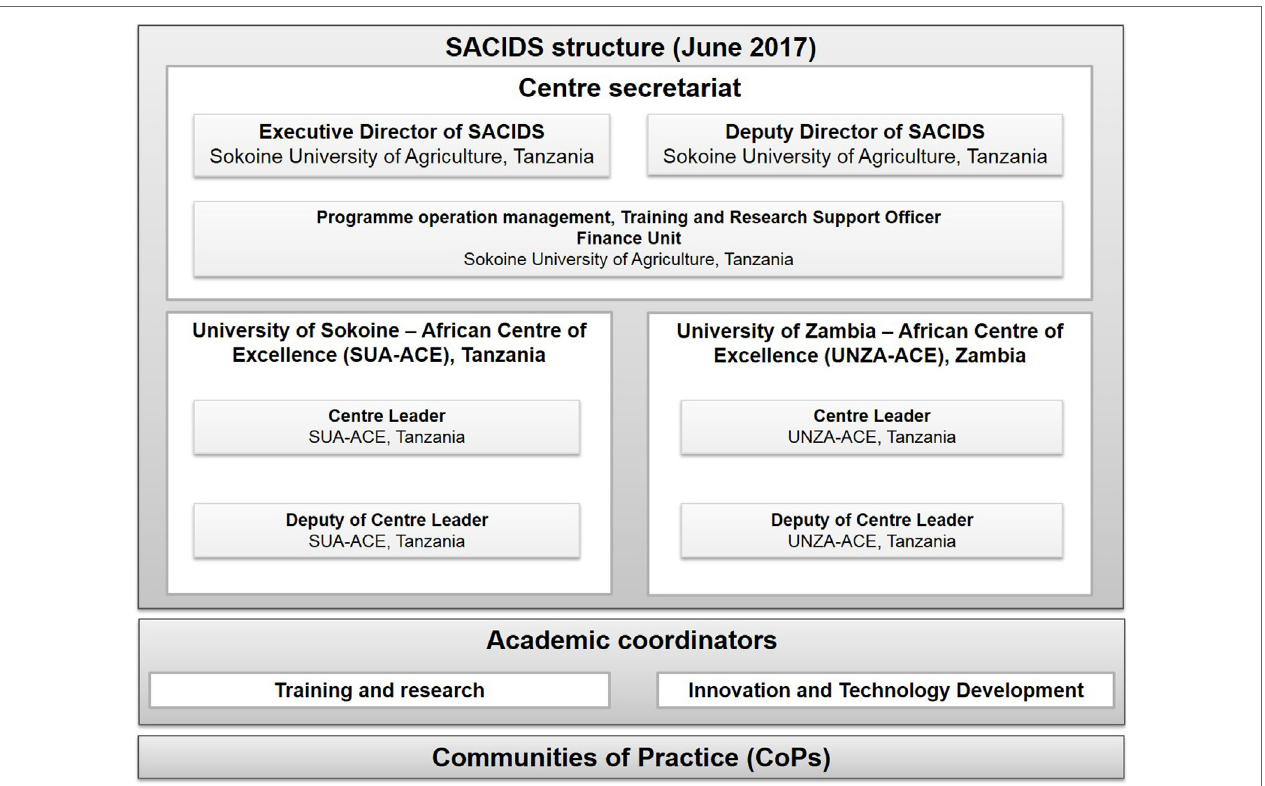
FigUre 3 | Southern African Centre for Infectious Disease Surveillance (SACIDS)’ structural organization at the regional